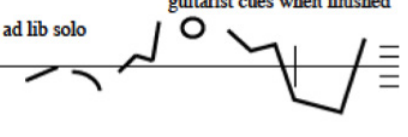
Figure 16. Guitar solo in bar 5.